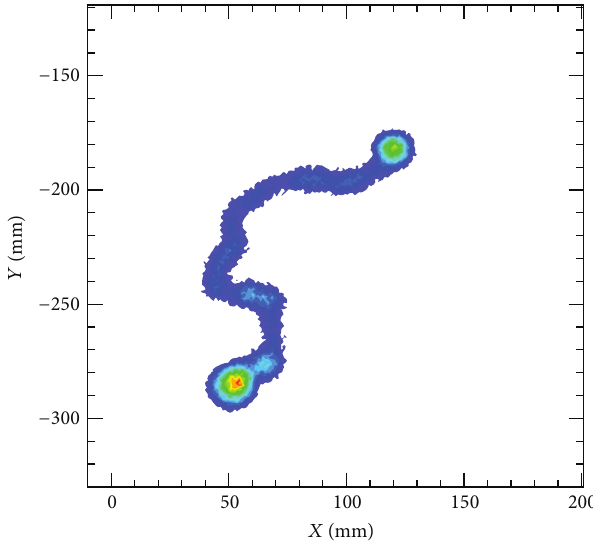
Figure3:MonteCarlosimulationofa 136 Xe 𝛽𝛽0 ] eventinxenongas at 10bar: the ionization track, about 30cm long, is tortuous because of multiple scattering and has larger depositions or blobs in both